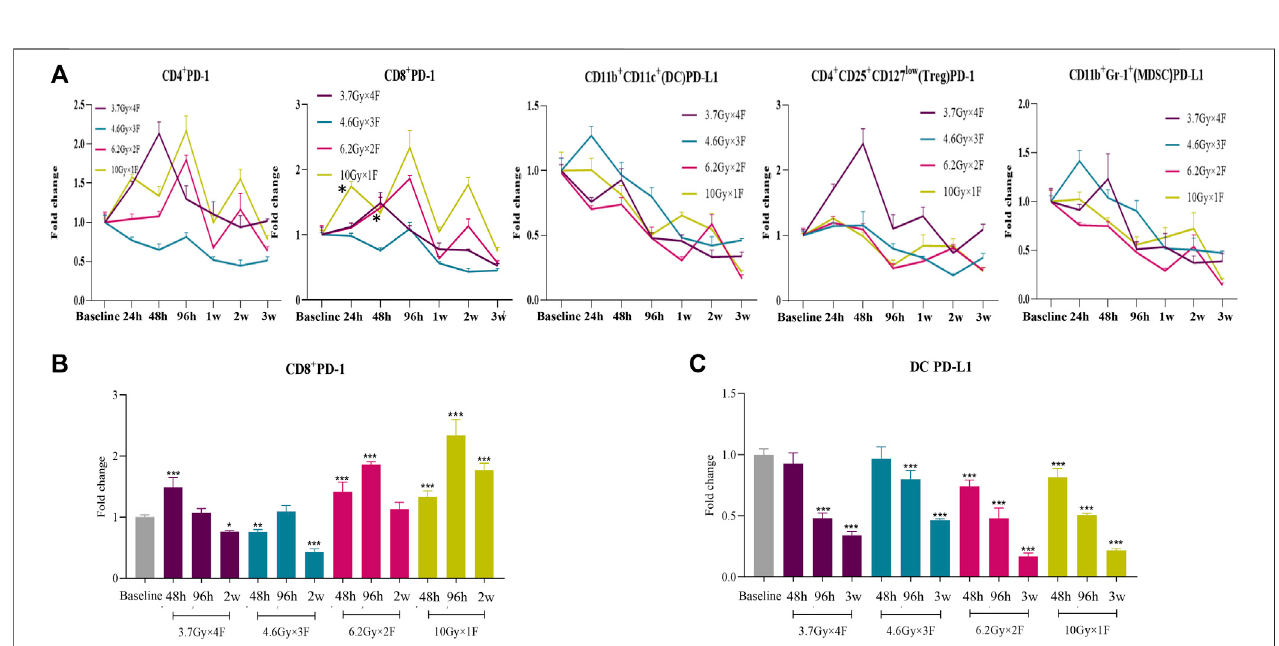
FIGURE3| DynamictrendsofPD-1andPD-L1expressionafterradiotherapyinLLCimplantedmouseperipheralblood. (A) TrendsofCD4 + PD-1,CD8 + PD-1,DC PD-L1, Treg PD-1, and MDSC PD-L1 after 4 different fractionation radiotherapies. * The dose in which trend was signi fi cant and the time at which difference began. (B) DiscrepancyofCD8 + PD-1at48 h,96 h,and2wafterradiotherapy,respectively. (C) DiscrepancyofDCPD-L1at48 h,96 h,and3wafterradiotherapy.* p ＜ 0.05,** p ＜ 0.01, *** p ＜ 0.001, compared with